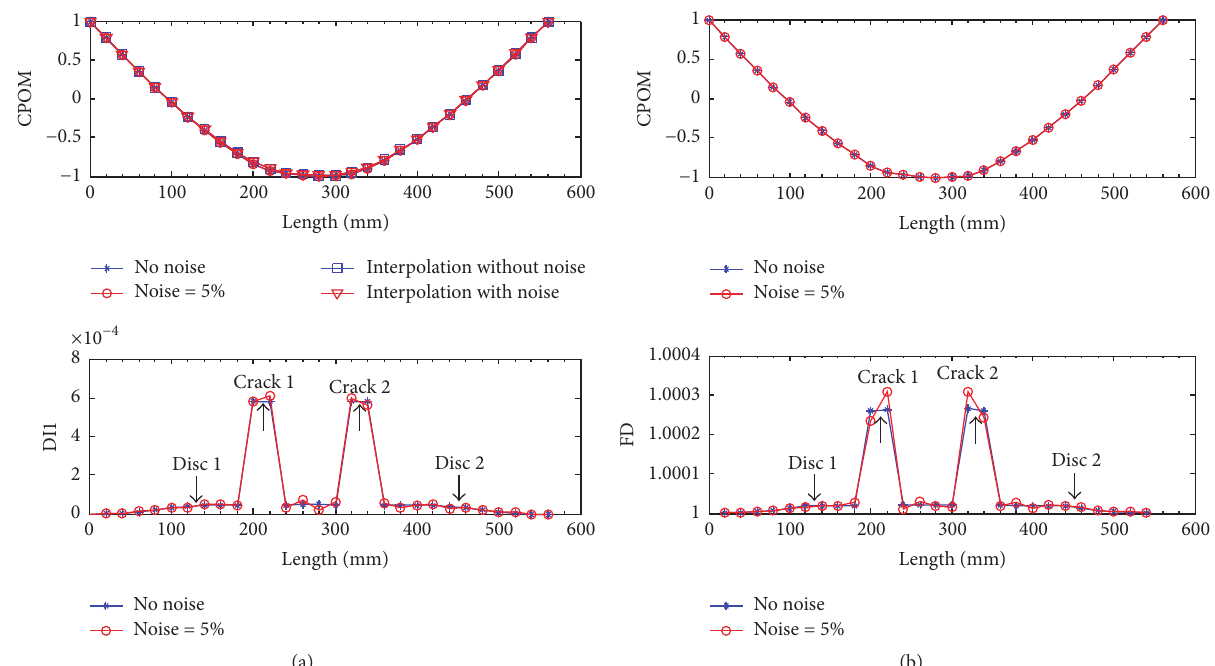
Figure 10: Localization results of double-cracked rotor in case 3. (a) Localization using GSM by linear gapped interpolation. (b) Localization using